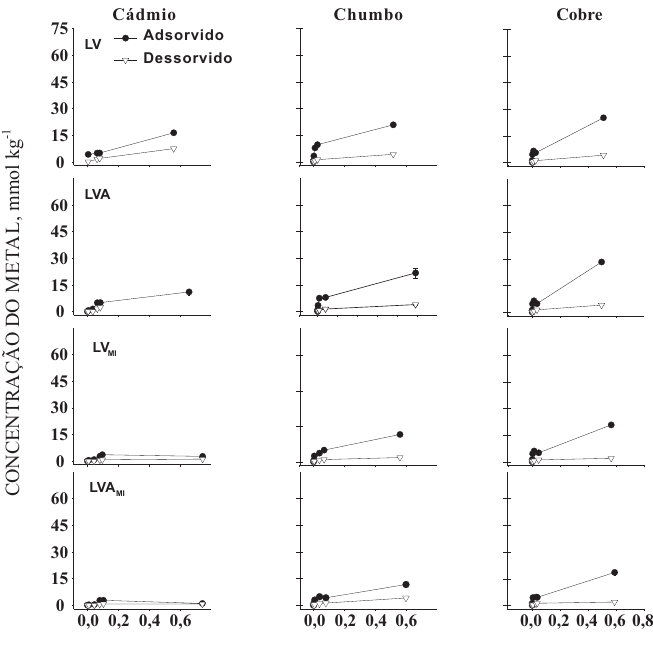
Figura 2. Isotermas de adsorção ( ) e dessorção ( ∇∇∇∇∇ ) dos metais Cd, Pb e Cu, de amostras de Latossolo Vermelho (LV) e Latossolo Vermelho-Amarelo (LVA), obtidas após reação destas com soluções dos metais, individual e simultaneamente (LV eLVA ), nas concentrações de 0,01; 0,05; 0,10; 0,15; e 0,75 mmol L -1 MI MI